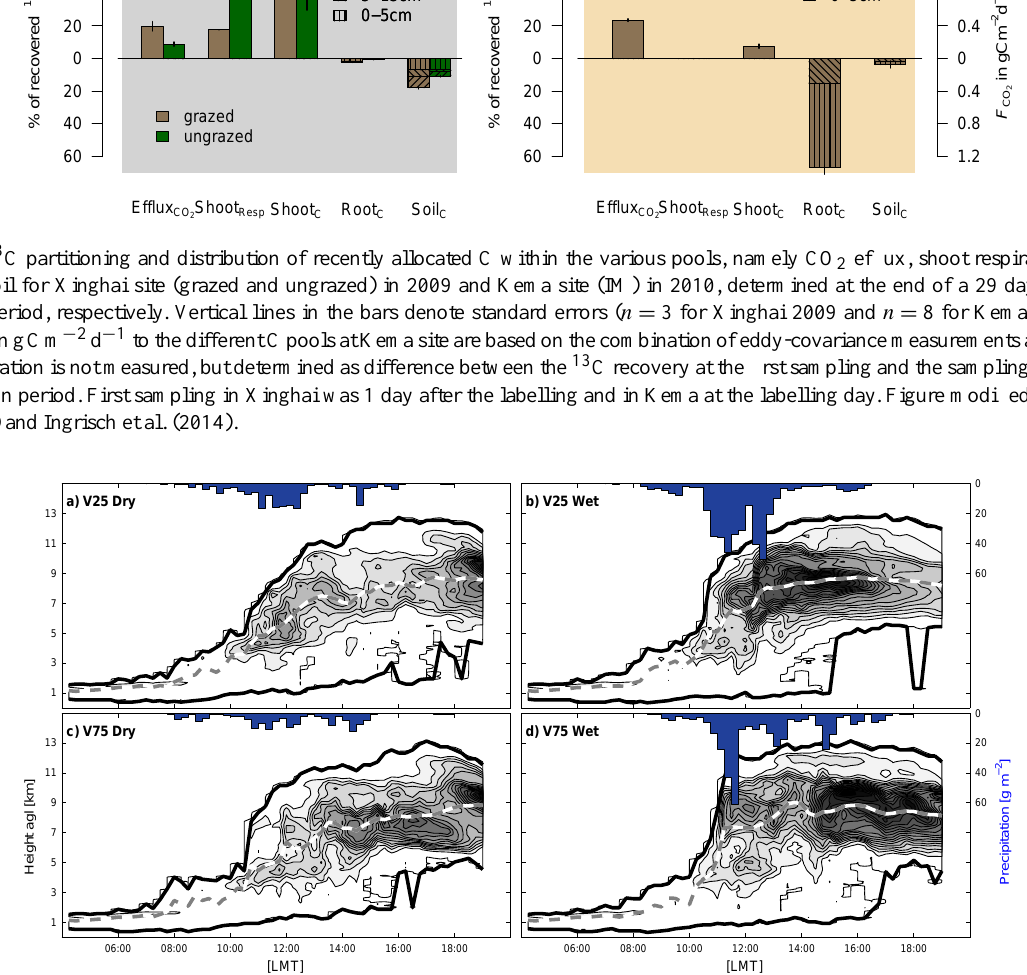
Figure 8. Simulated convection development and deposited precipitation (blue bars) for a symmetric Tibetan Valley with 150km width. The black lines indicate cloud base and cloud top in kilometres above ground level; the dashed line shows the centre of the cloud mass and the contours give the mean cloud water and ice concentration integrated over the model domain. V25 and V75 refer to 25% and 75% vegetation cover, while wet and dry indicate initial soil moisture corresponding to 1.0 and 0 . 5 × field capacity, respectively. Times are given in local mean time (LMT), which is two hours before Beijing standard time